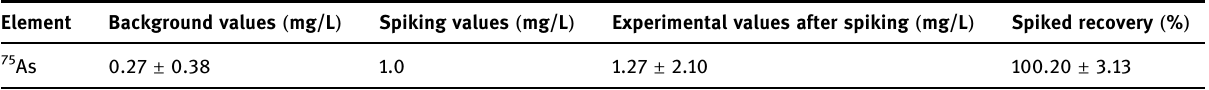
Table 3: ICP - MS sample addition and recovery experimental data ( n = 3 )